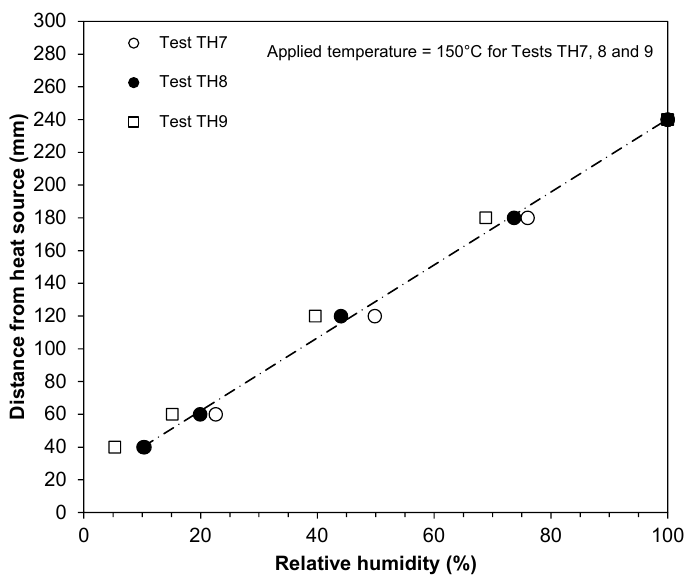
Figure 12. Relative humidity profiles in the non-isothermal hydraulic tests at 150 °C.